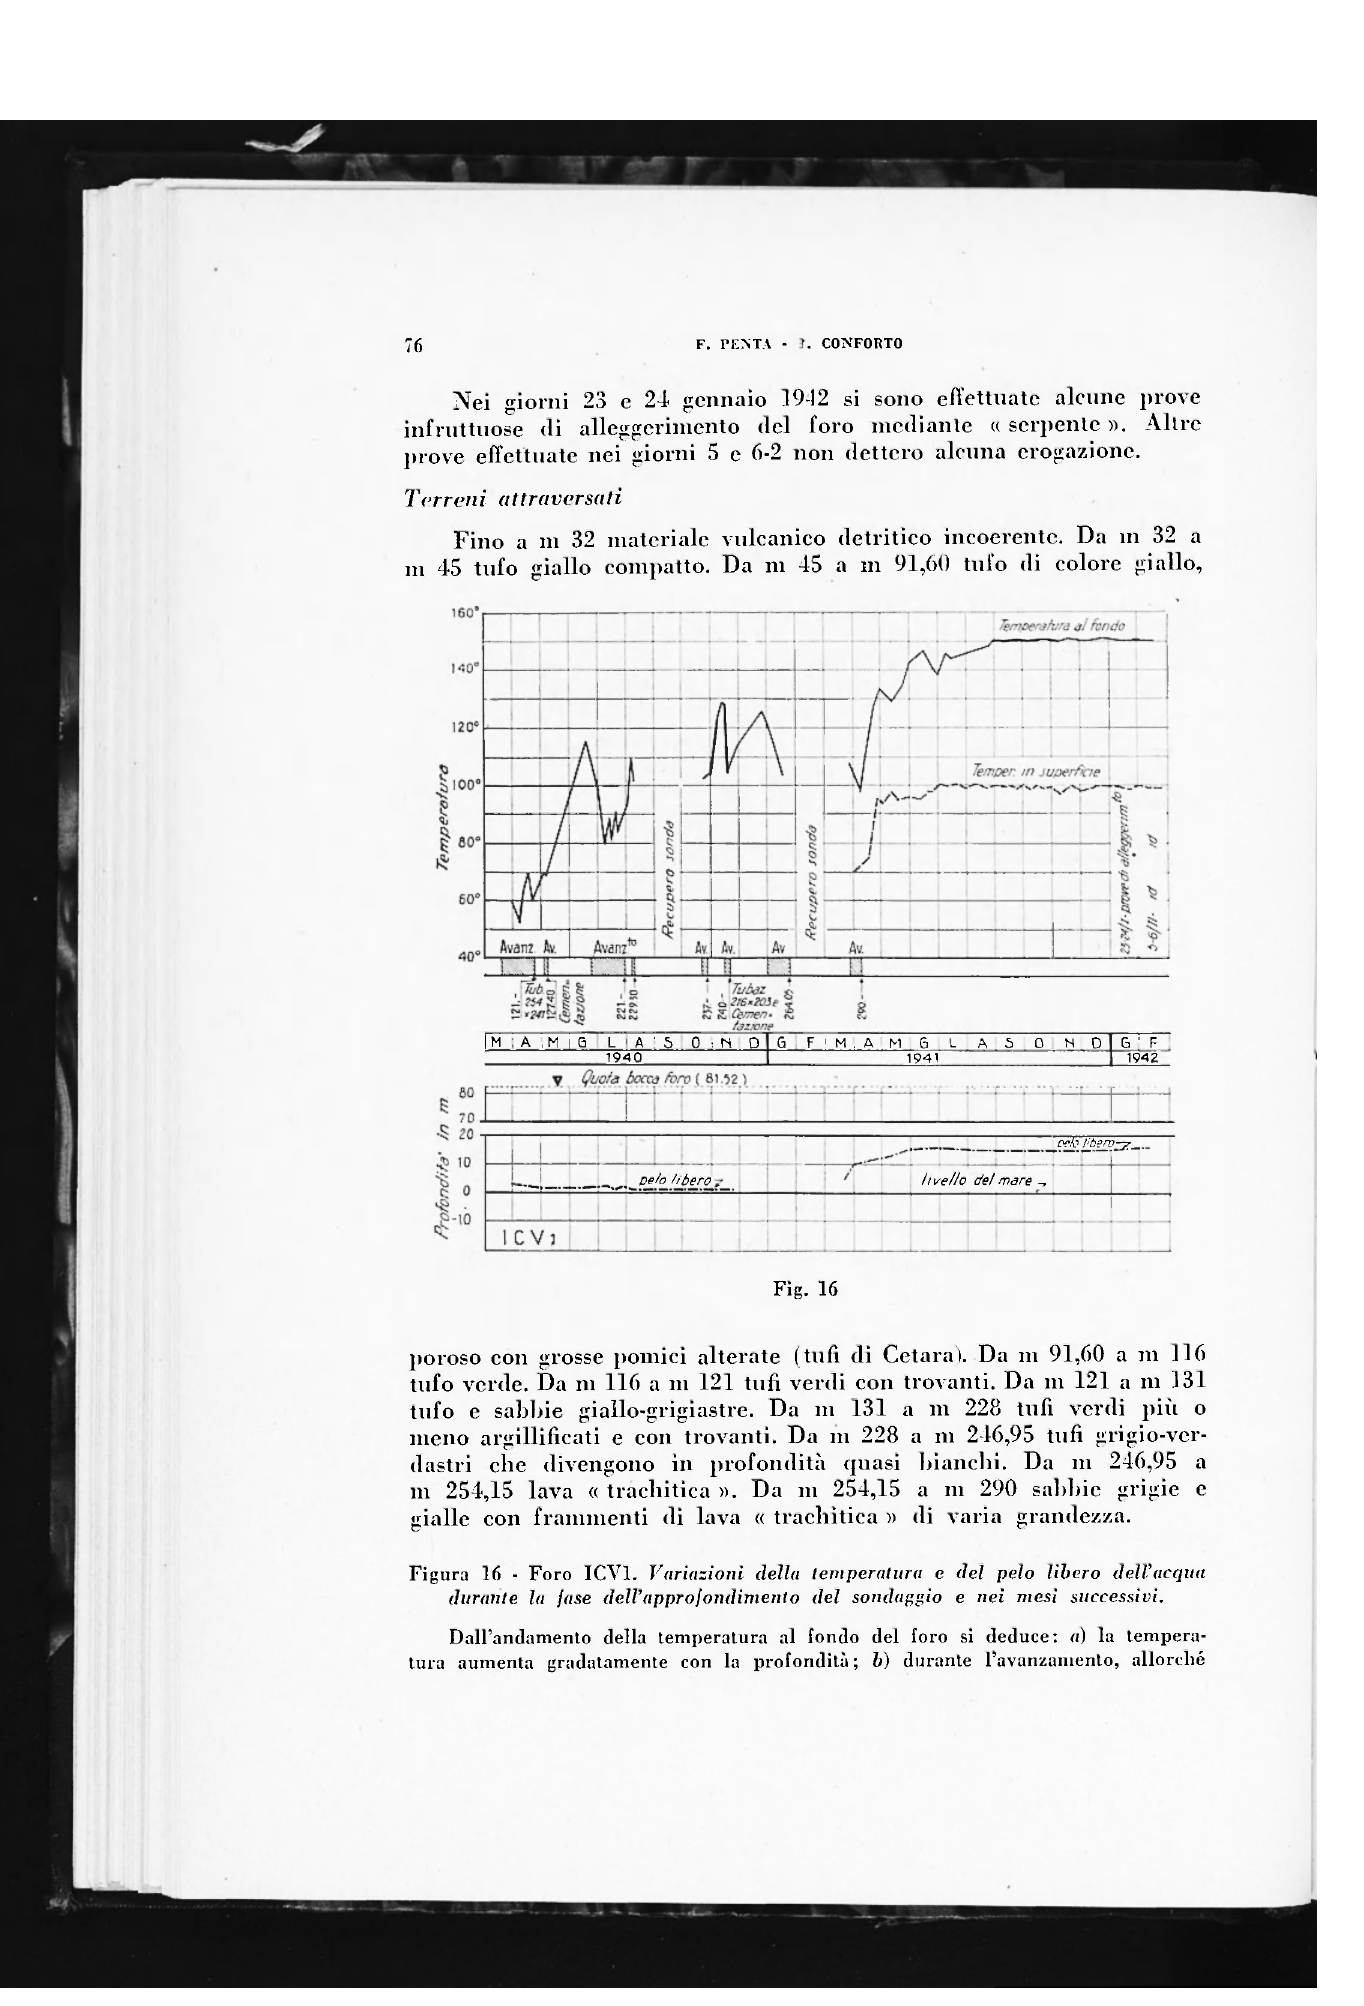
Figura 16 - Foro ICV1. Variazioni della temperatura e del pelo libero dell'acqua